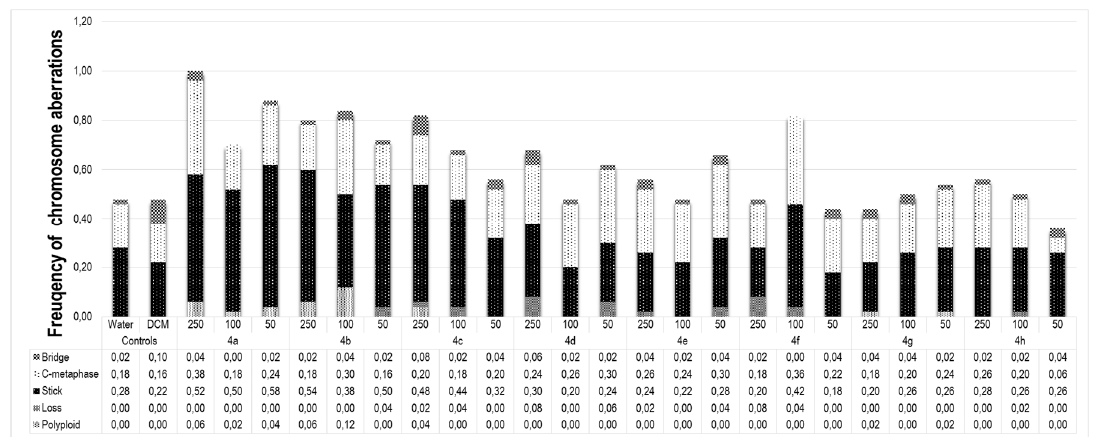
Figure 2. Distribution of the frequency of bridge, c-metaphase, stick, loss and polyploid observed in meristematic cells of Lactuca sativa using three different concentrations (50, 100 and 250 µg mL − 1 ) of the triazoles 4a – 4h .